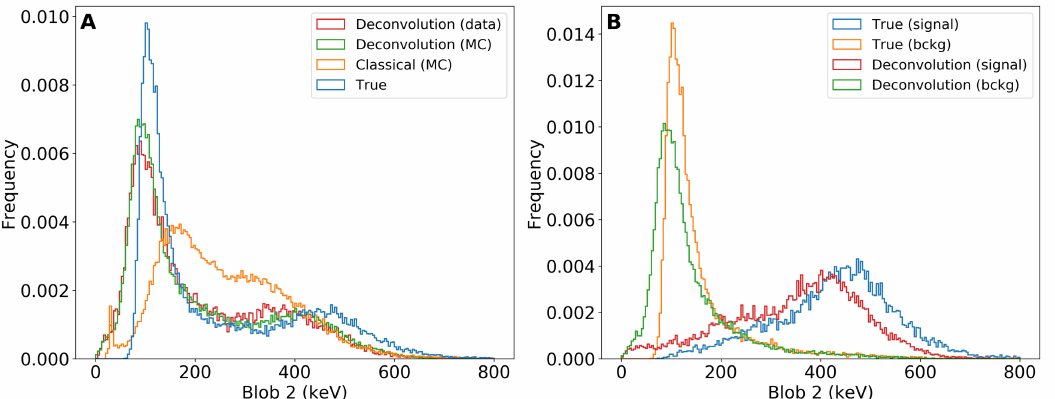
Figure 14 . (A) Reconstructed energy for blob2 for deconvolution and classical analysis. The “true” blob energy is found by integrating over a sphere of 18 mm radius centered on the true track end-point. (B) Distributions divided by population, either signal or